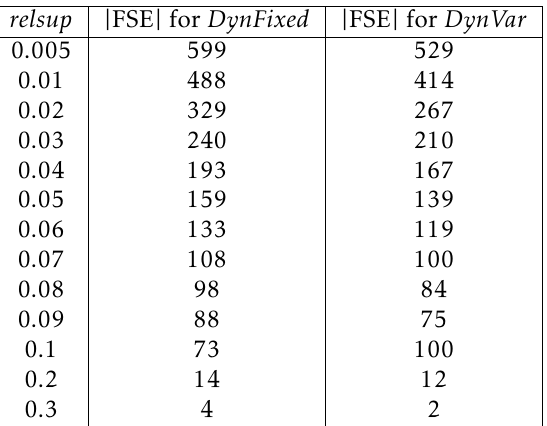
Table 17. Number of frequent singleton edges (|FSE|) for paths data with varying relative support( relsup ) for proposed dynamic approach with fixed batch size ( DynFixed ) and variable batch size